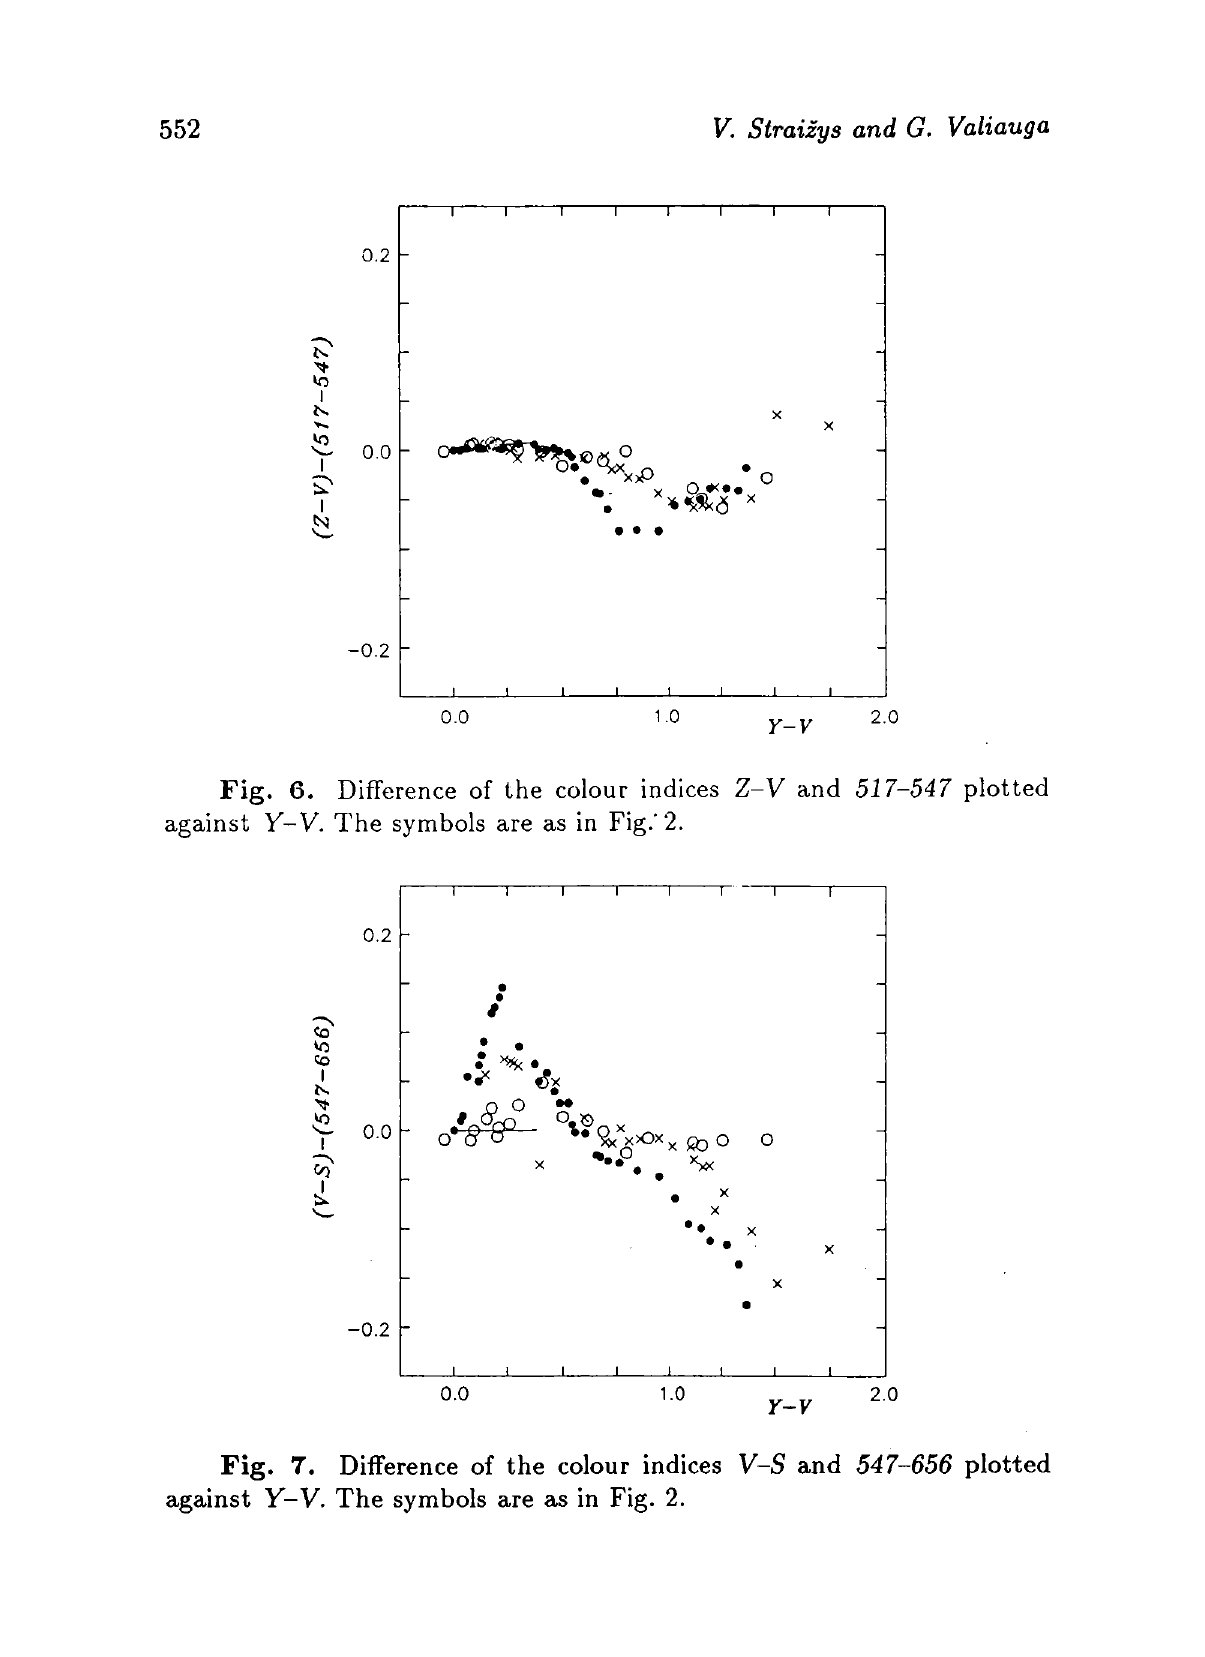
Fig. 7. Difference of the colour indices V-S and 547-656 plotted against Y-V. The symbols are as in Fig.